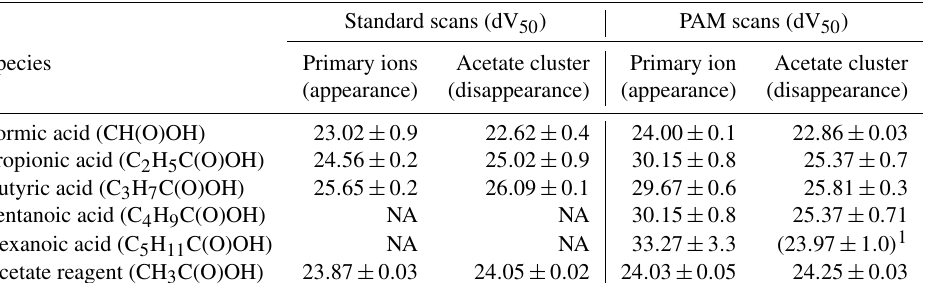
Table 2. Alkanoic acid species scanning results during authentic standard API scanning (left column) and PAM chamber scanning (right column). dV 50 values are reported for the deprotonated-declustered ions (increasing signal with increasing dV) and for the acetate-clustered ions (decreasing signal with increasing dV).